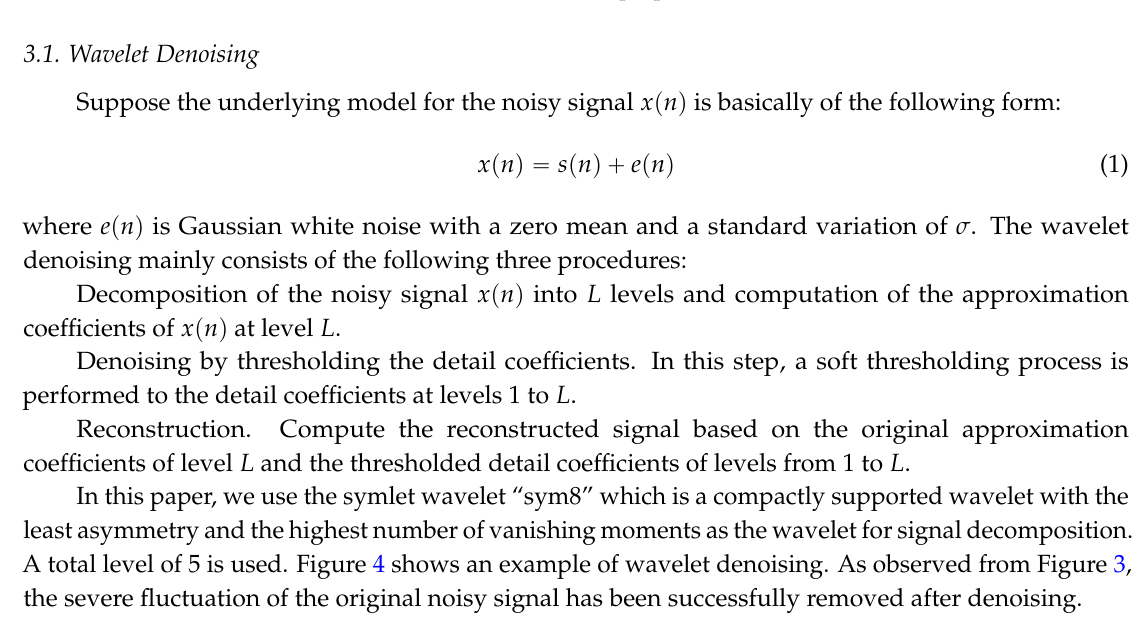
Figure 3. Flow chart of the proposed method.